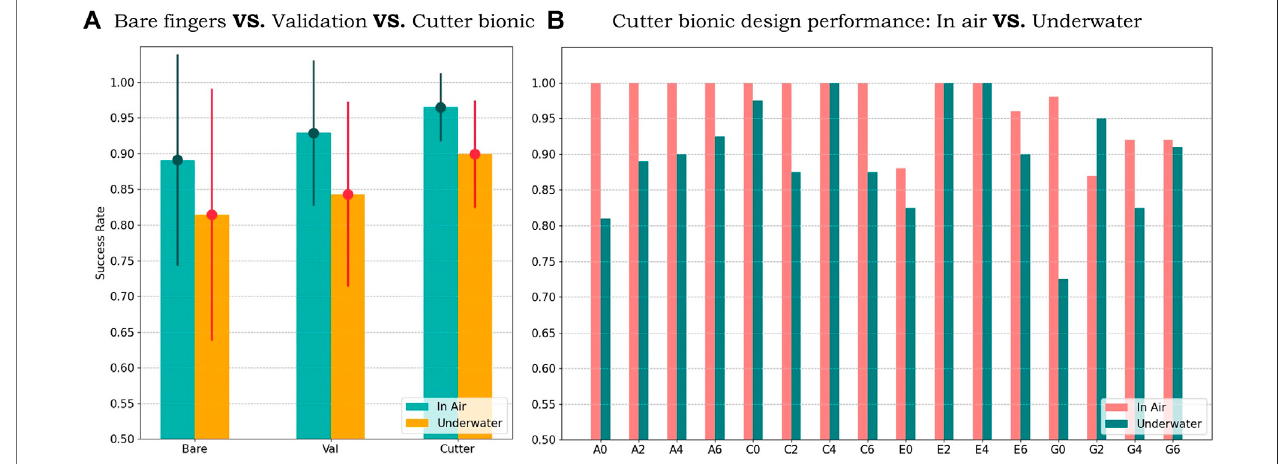
FIGURE12|(A) The performances ofthebare fi ngers, validation design, and optimal cutterbionic design on 16objects in air(on land)and underwater, withmean and variance. (B) Optimal cutter bionic design performance detail on 16 objects, in air (on land) and underwater.